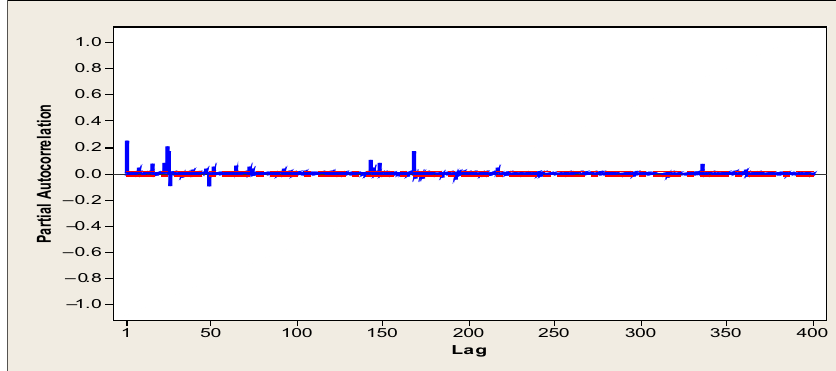
Figure 5. ACF of the squared residuals of DSARIMA model Lag